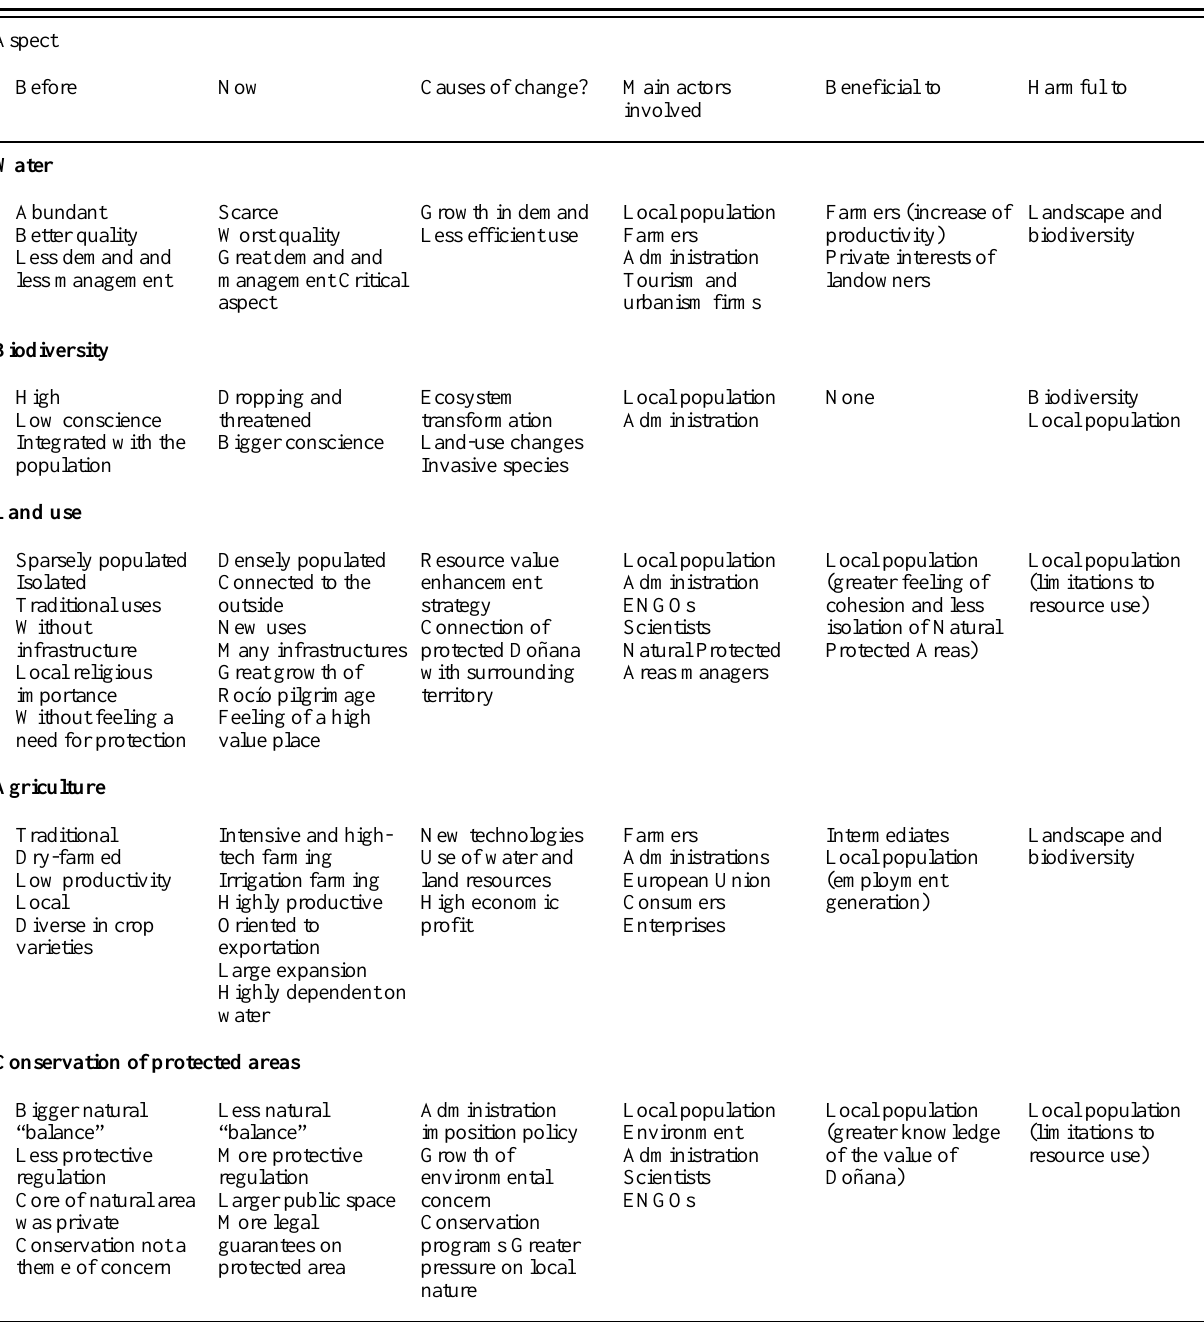
Table 1 . Main aspects of Doñana, according to the participants of the